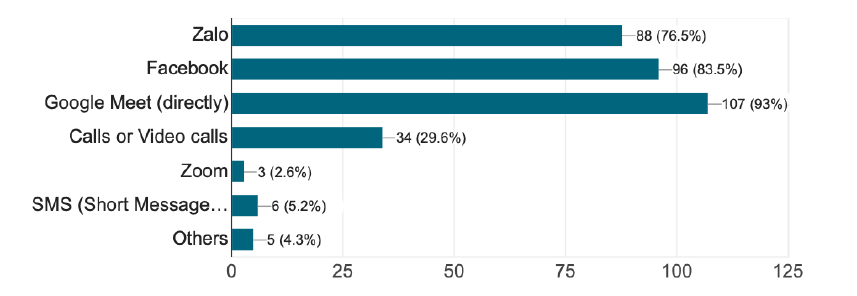
Fig. 2. Participants’ means of interaction with other students